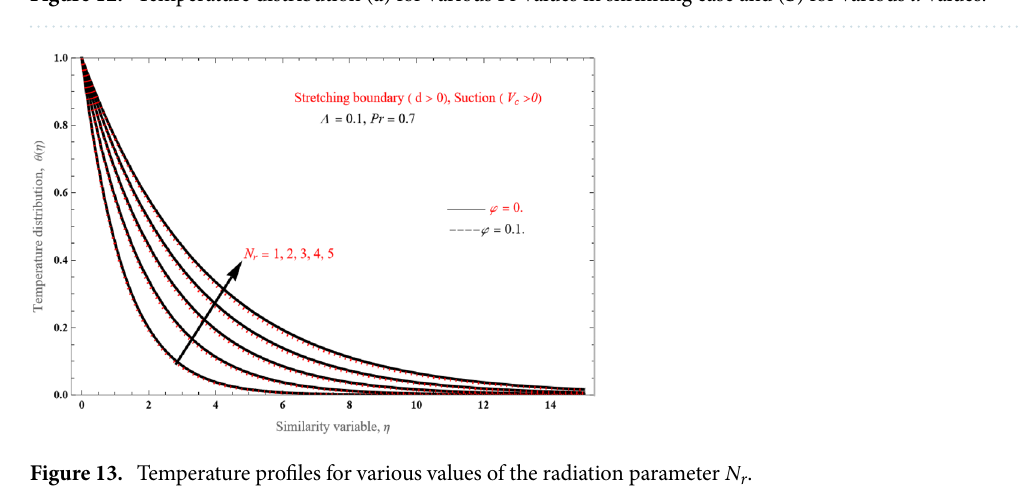
Figure 12. Temperature distribution ( a ) for various Pr values in shrinking case and ( b ) for various d values.